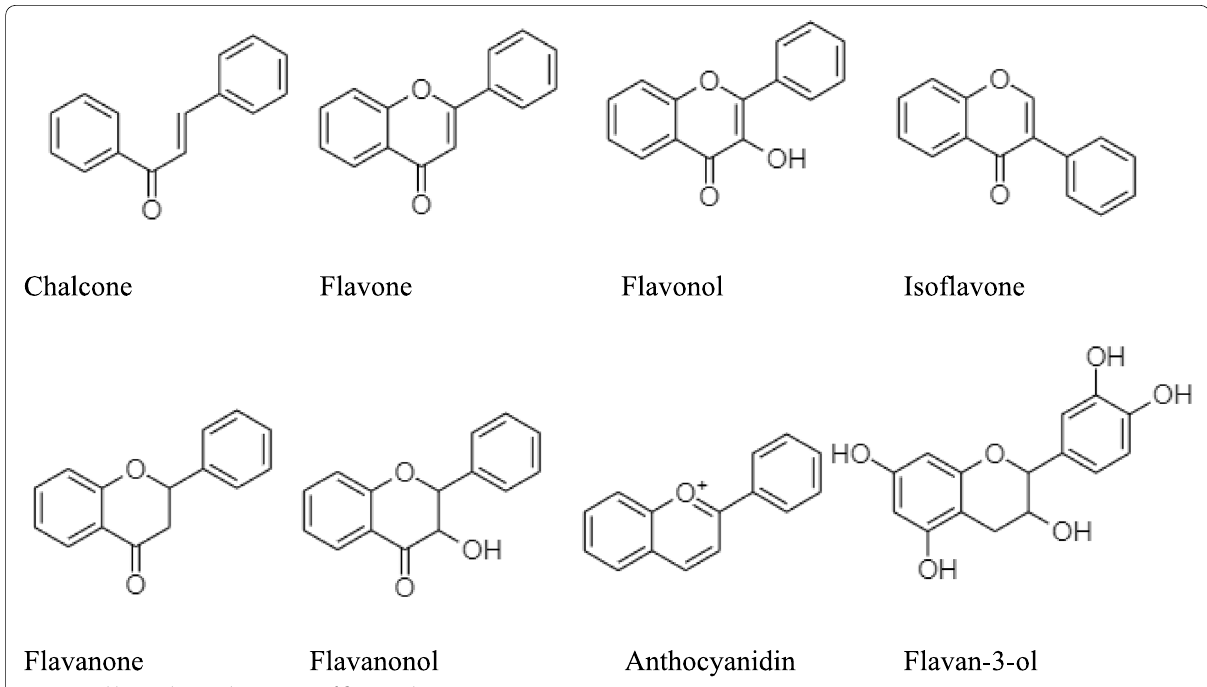
Fig. 4 Backbone chemical structures of